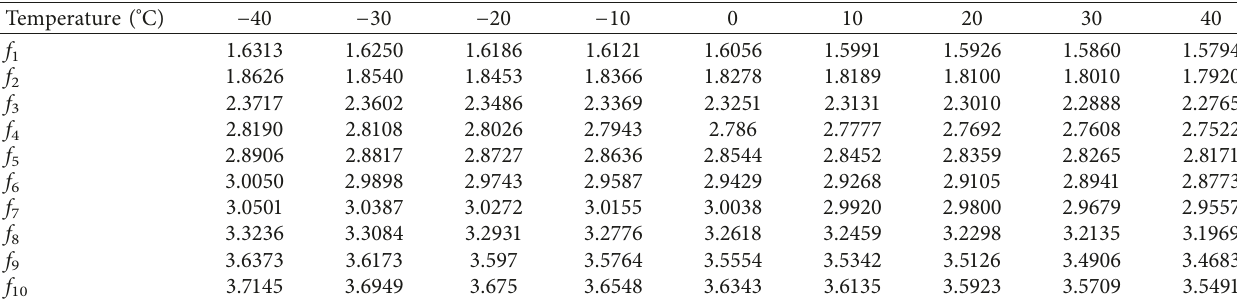
Table 4: Frequency of the first 10 vibration modes of the CSBV with steel strand cables (unit: Hz).